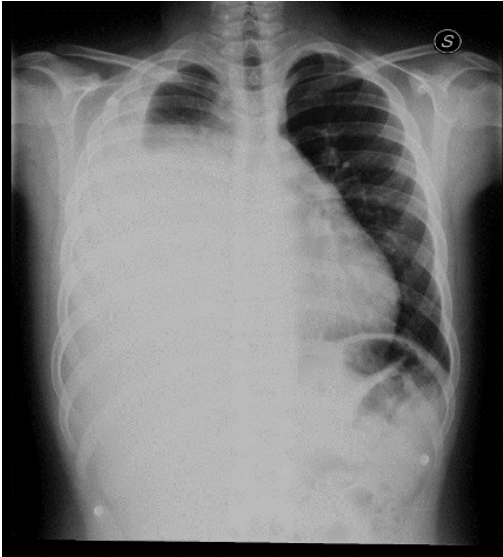
Figure 1. Chest X-ray performed in the emergency department. The exam showed an extensive and inhomogeneous hypodiaphania extending from the upper third to the lower third of the right lung as for pneumonia with a pleural effusion in the right hemithorax associated. The upper lung pole appeared hypoexpanded.